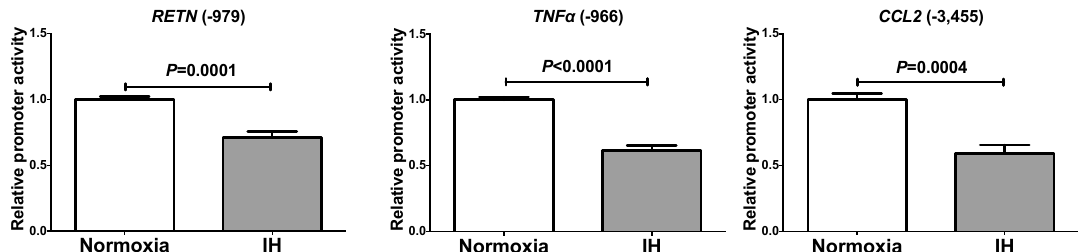
Figure 5. Luciferase assays of promoter activities of RETN , TNF α , and CCL2 in SW872 cells. Reporter plasmids prepared by inserting the promoter fragments of RETN ( − 979~+20), TNF α ( − 966~+19), and CCL2 ( − 3455~+25), upstream of a firefly luciferase reporter gene in pGL4.17 vector were transfected into SW872 cells. After cells were exposed either to IH or normoxia for 24 h, the cells were lysed and the promoter activities of RETN , TNF α , and CCL2 were measured. All data are represented as the mean ± SE of the samples ( n = 5–6). The statistical analyses were performed using Student’s t -test.